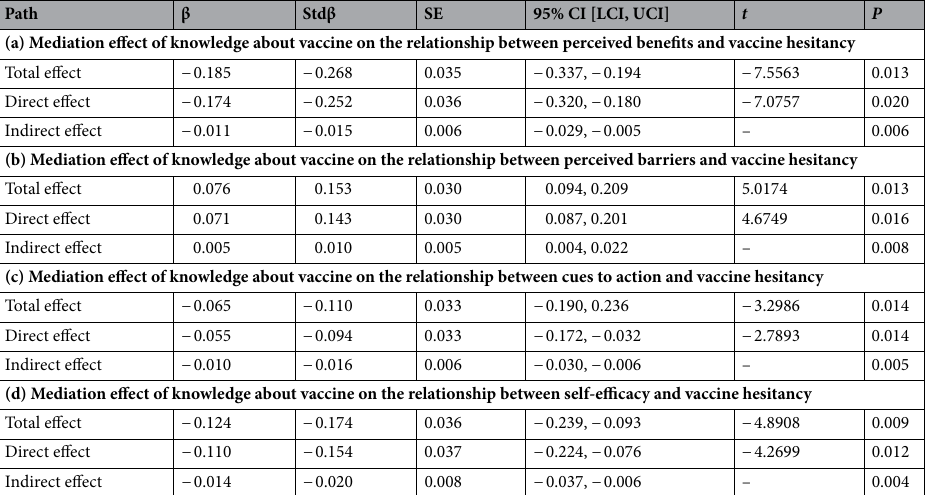
Table 6. The mediating effects of knowledge about vaccine on the relationship between HBM constructs and vaccine hesitancy. All parameters obtained from the AMOS output with the HBM dimensions: perceived susceptibility (not significant), perceived severity (not significant), perceived benefits, Perceived barriers, cues to action and self-efficacy; β—unstandardised beta co-efficient; Stdβ—standardised beta co-efficient; SE— standard error; 95% CI—95% confidence interval with lower bounds and upper bounds [LCI, UCI]; t—t value, p —shows the significant level.